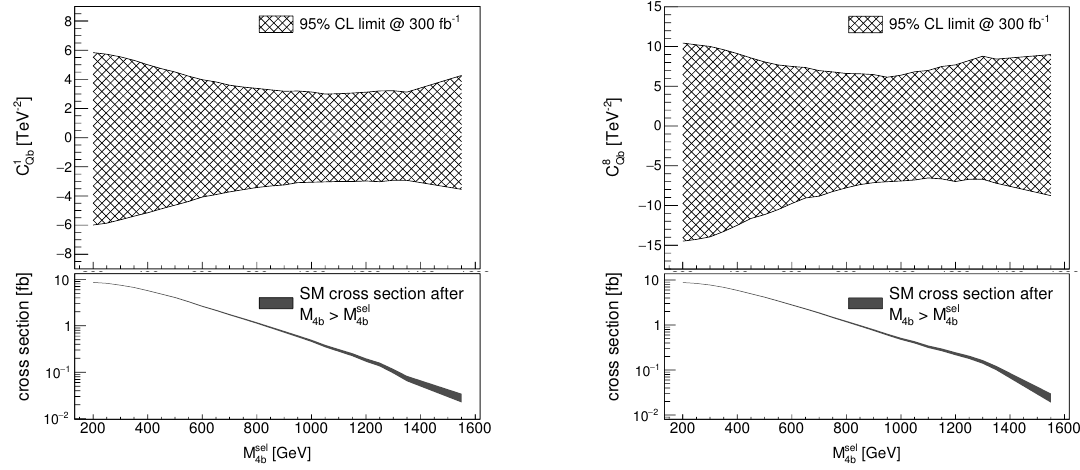
Figure 7 . Individual limits at 95% CL on C 1 invariant mass of the 4 b -jets in the event ( M sel section as a function of M sel grey